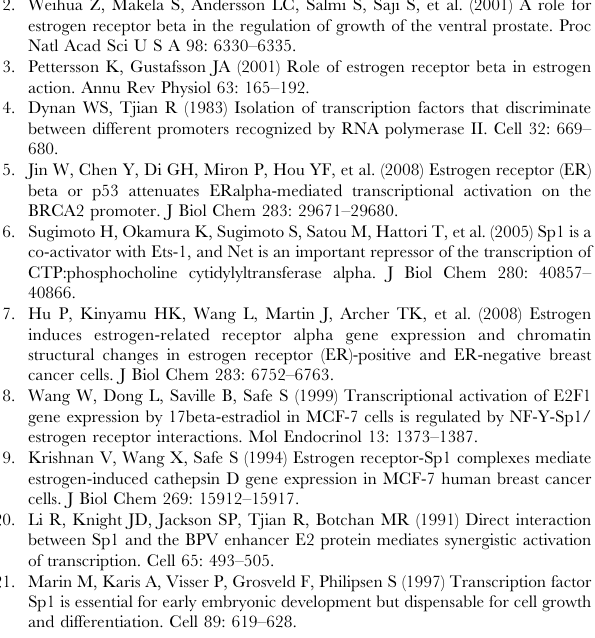
Figure S1 Detection of basal activity of the MGARP promoter by red fluorescence.